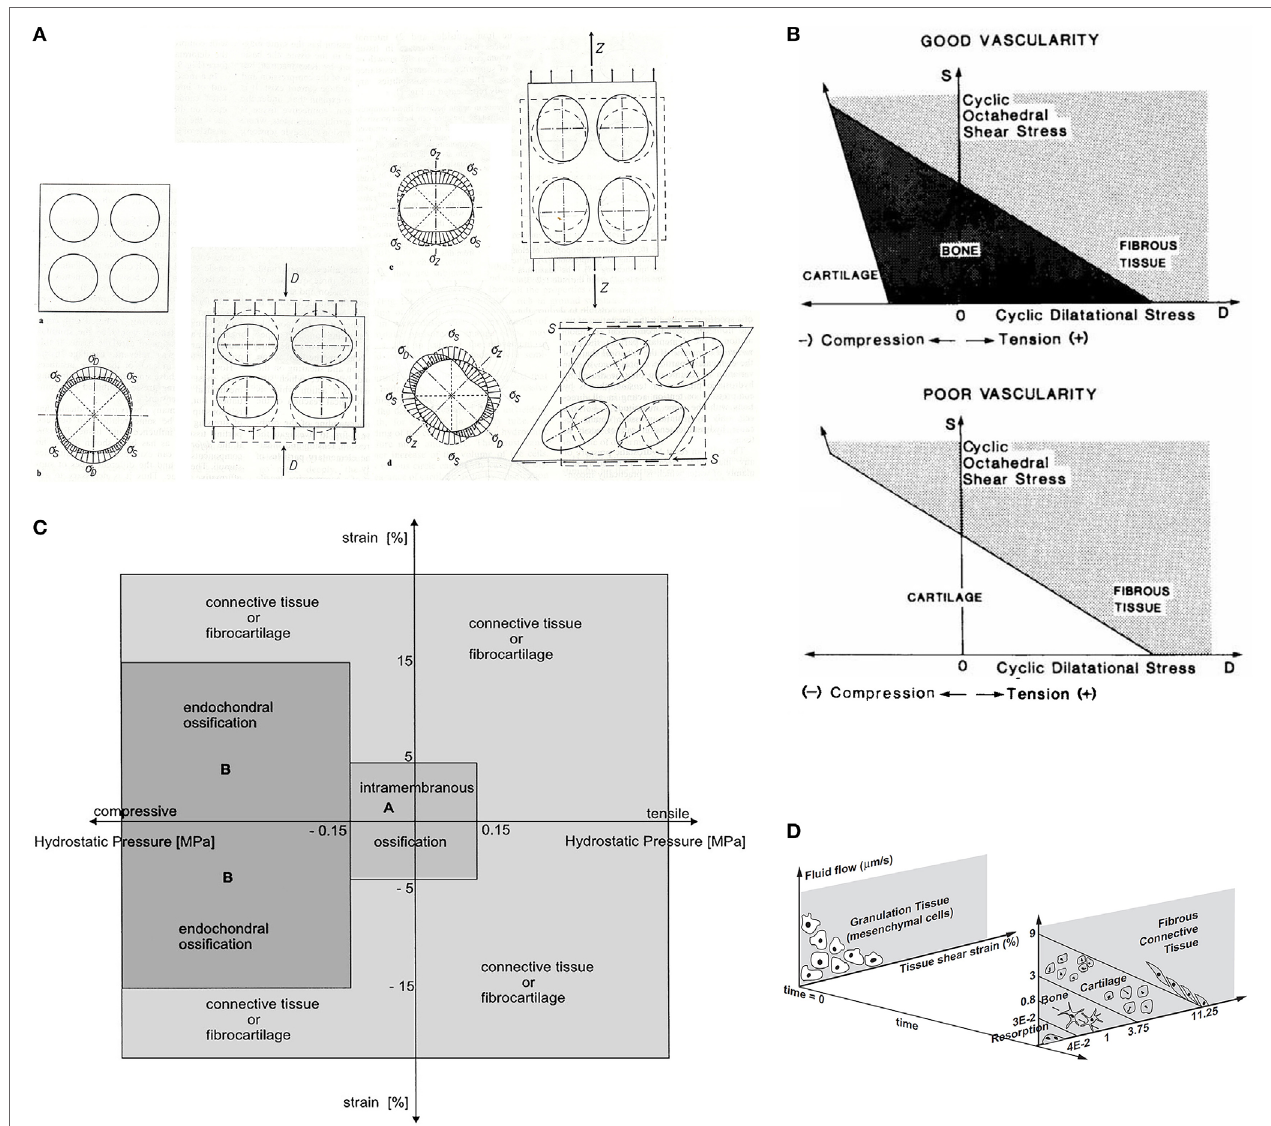
FigURe 2 | Multiple mechano-regulation models that predict tissue development based on different mechanical stimuli . Panel (A) shows the model of Pauwels where an elementary sphere suspended in mesenchyme tissue subjected to compression, tension, and shear causes cells to form collagen fibrils. Hydrostatic pressure results in chondrogenesis while bone is formed on an existing solid framework. Panel (B) shows the model of Carter. With good vascularization, low distortional (octahedral shear stress), and volumetric (hydrostatic pressure) stresses results in bone formation, intermediate stresses in cartilage, and high stresses in fibrous tissue. Poor vascularization inhibits bone formation. Panel (C) shows the model of Claes and Heigele which dictates that low volumetric stress (0.15 MPa hydrostatic pressure) and low local distortional strain (5%) results in intramembranous ossification while hydrostatic pressures <− 0.15 MPa with local strains between − 15 and 15% results in endochondral ossification. Other hydrostatic pressures and strains results in connective tissue or fibrocartilage. Panel (D) shows the model of Prendergast where a distortional strain (tissue or octahedral shear strain) and interstitial fluid flow through mesenchyme tissue stimulates the mesenchymal cell to differentiate and form a tissue. The cell and formed tissue will be replaced by other cell types and tissue based on the perceived biophysical stimuli. Replacement of the cell and tissue population continues until the formed tissue withstands the biophysical stimuli and an equilibrium occurs. Adapted with permission from Pauwels (1960), Carter et al. (1988), Claes and Heigele (1999), and Lacroix and Prendergast (2002),